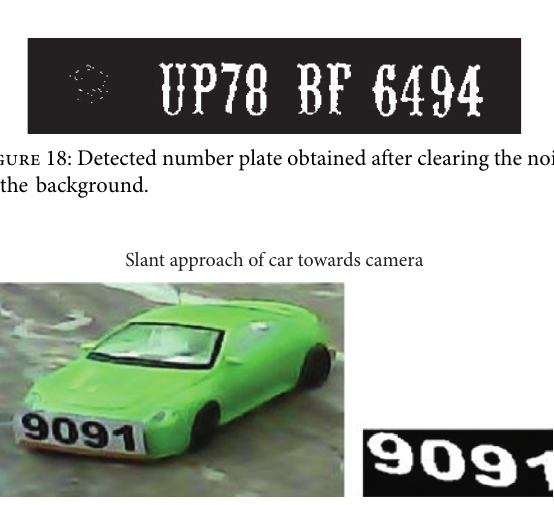
Figure 19: Slant approach of the car towards the camera and the detected number plate.